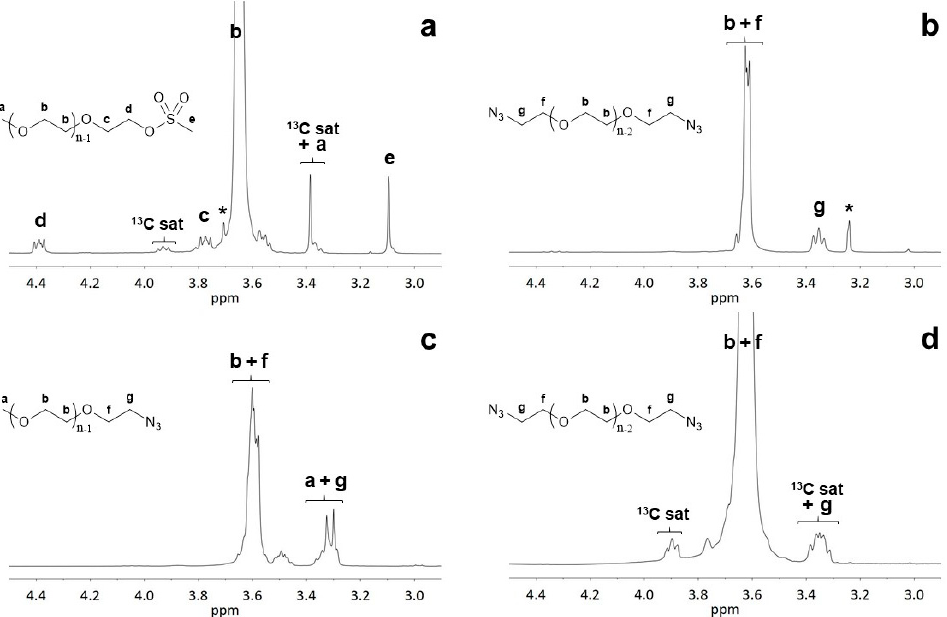
Figure 1. 1 H NMR spectra of mPEG 2000 -Oms ( a ) and N 3 -PEG 400 -N 3 ( b ), mPEG 350 -N 3 ( c ), N 3 -PEG 7800 - N 3 ( d ). Mark (*) denotes signal due to residual methanesulfonic acid or undeuterated solvents. Table 2. Summary of functionalization e ffi ciency and molecular characteristics obtained from 1 H NMR. Adduct